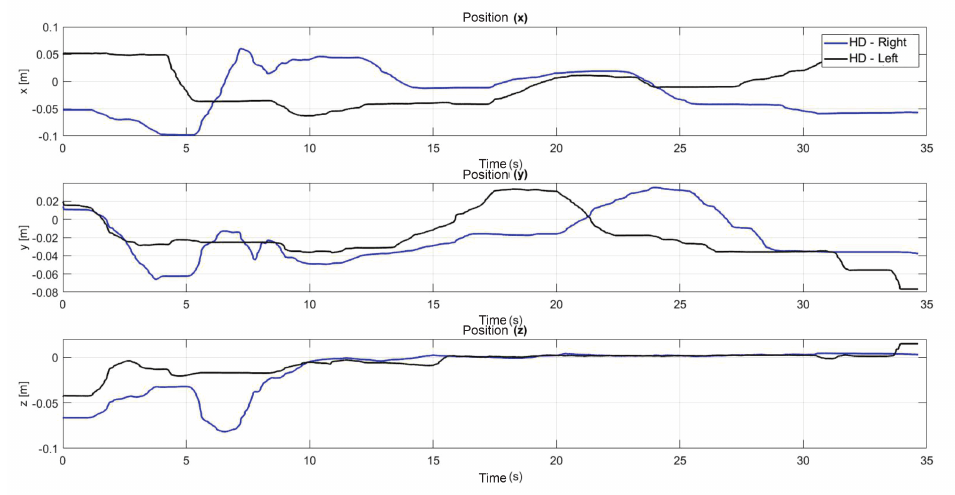
Figure 16. Operational position of two haptic devices in active haptic guidance task for SCM.